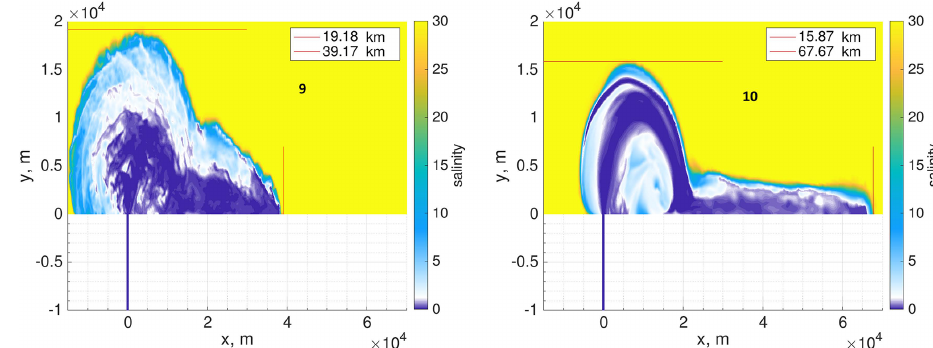
Figure 12. The surface salinity at 35h, in practical scale, from runs 9 and 10 with a reduced number of sigma layers.